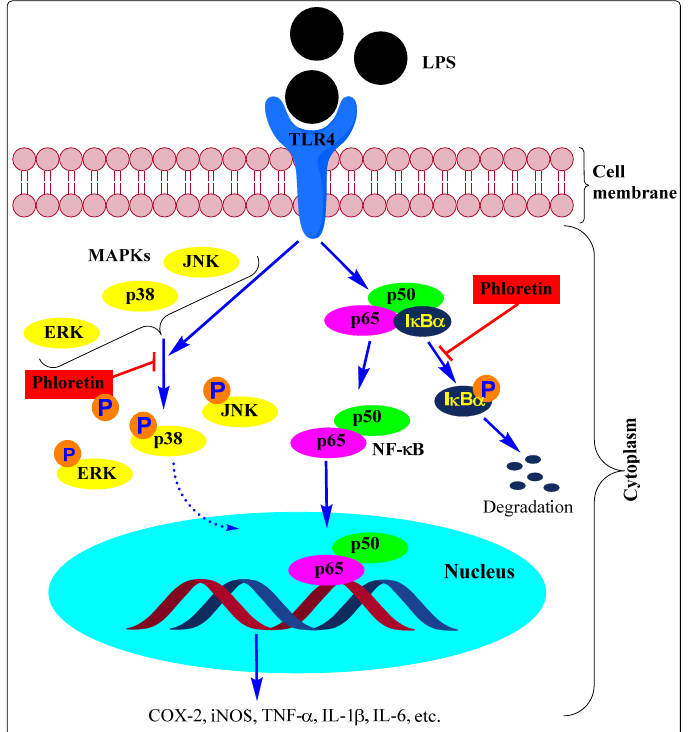
Figure 2. Anti-inflammatory effect of phloretin through inhibition of phosphorylation of MAPKs and I κ B α . Most of the studies on the activation of inflammatory mediators from immune cells employed LPS which interacts with its receptor, TLR4. While a direct effect on TLR1/2 has been suggested, most of the data indicate an inhibitory effect on NF- κ B mobilization to the nucleus. The LPS response shown by blue arrows includes the degradation of the NF- κ B inhibitory protein, I κ B α , via promoting its phosphorylation. This frees the p65/p50 to mobilise to the nucleus and activate inflammatory target genes such as COX, iNOS, and cytokines including TNF- α , IL-1 β , and IL-6. Phloretin has been shown the suppress the NF- κ B activity by inhibiting I κ B α degradation (see red lines). The exact mechanism of how the MAPK activity leads to the activation of proinflammatory genes has not yet been fully established but the key steps after induction by inflammatory agents such as LPS is